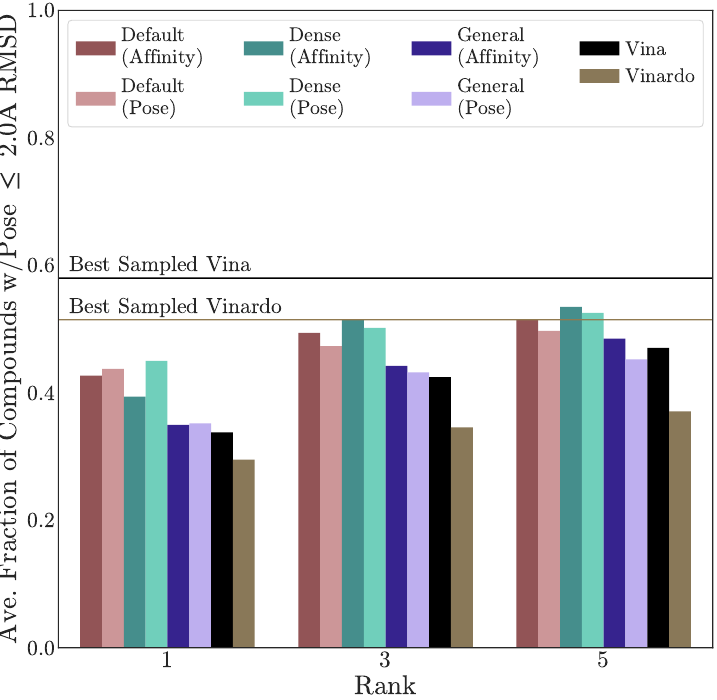
Figure 4. Assessment of cross-docking performance on LIT-PCBA structures. The percent of a target’s compounds with a good pose at ranks 1, 3, and 5, averaged across all thirteen targets in LIT-PCBA with more than one template available is shown. Labeled horizontal lines show the best performance possible with the poses sampled by Vina and